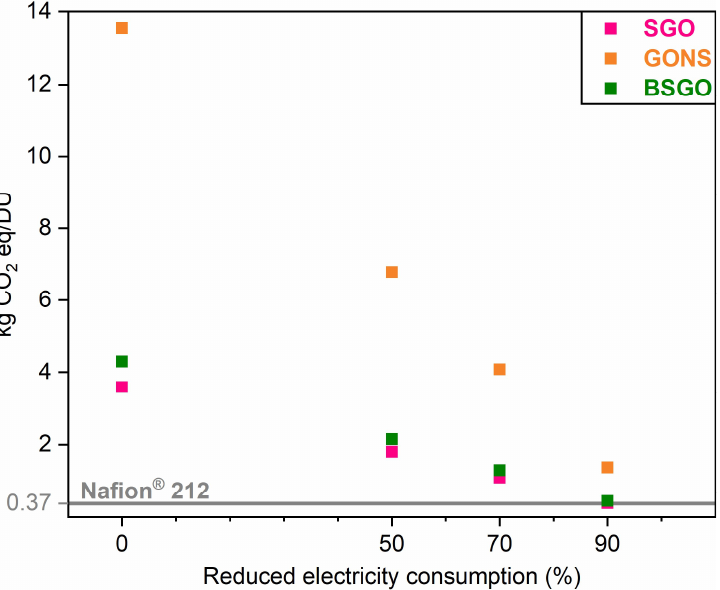
Figure 9. Sensitivity analysis on the climate change impact of Nafion ® 212, SGO, GONS, and BSGO, considering electricity consumption reduced by 50%, 70%, and 90% of the original value for the laboratory procedures.